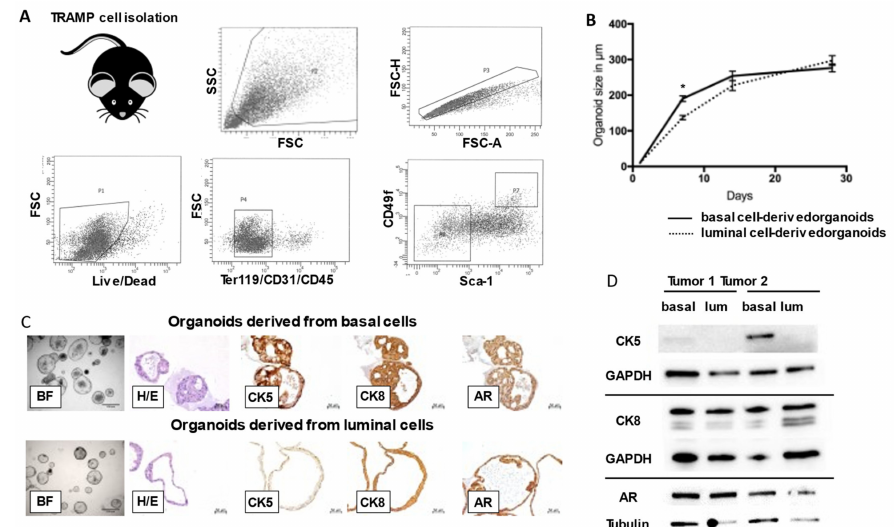
Figure 1. Establishment of basal cell-derived and luminal cell-derived organoid lines from TRAMP tumors. ( A ) Representative gating strategy for primary TRAMP tumor single cell suspension staining and sorting. Cells were sorted according to LIVE/DEAD yellow staining, negative blood lineage marker staining, and basal cell markers expression (Sca-1/CD49f), as previously published by our group [23]. ( B ) Basal cell-derived organoids and luminal cell-derived organoids exhibit no significant differences in maximum organoid size, although basal cell-derived organoids grow relatively faster within week one after plating. ( C ) Representative brightfield, hematoxylin/eosin, and immunohisto- chemistry analyses of TRAMP tumor cell-derived organoids shows differences in cellular architecture and protein expression between organoids of basal and luminal origin. Interestingly, basal cells isolated from TRAMP tumors gave rise to multilayered organoids strongly expressing the basal cell marker CK5 as well as CK8 and AR (upper panel), while luminal cell-derived organoids mainly grew as monolayered organoids not expressing CK5 (lower panel). Scale bars represent 50 µ m. ( D ) Immunoblotting experiments of basal and luminal-cell derived organoid lines derived from two individual TRAMP tumors show relatively higher expression of CK5 in basal cell-derived organoids (basal) when compared to luminal cell-derived organoids (lum). No differences between organoid origins are seen in expression of the luminal cytokeratin CK8 or the androgen receptor (AR). Original Western blot can be found in File